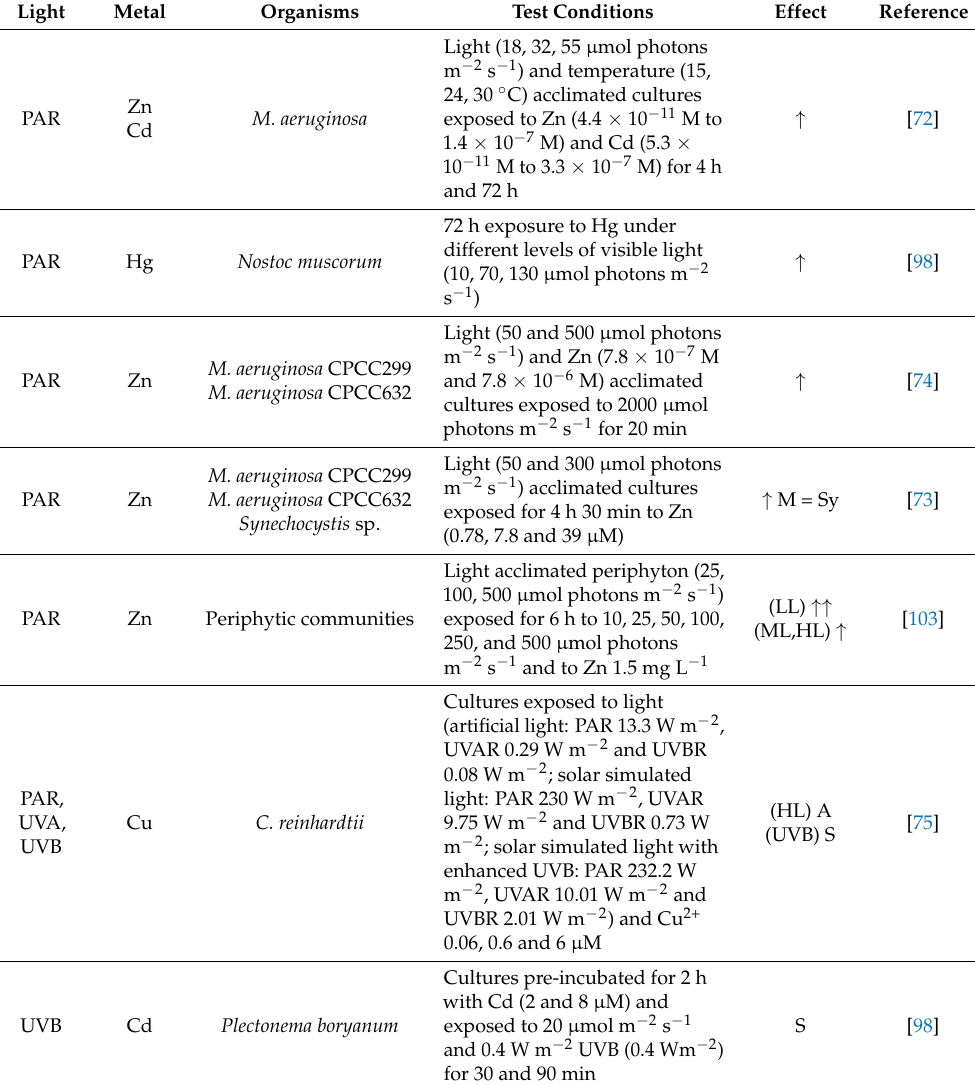
Table 1. Example of studies investigating the combined effects of metal and light irradiation (Visible and UVR) on phytoplankton species and communities (effects on photosynthesis and/or cell